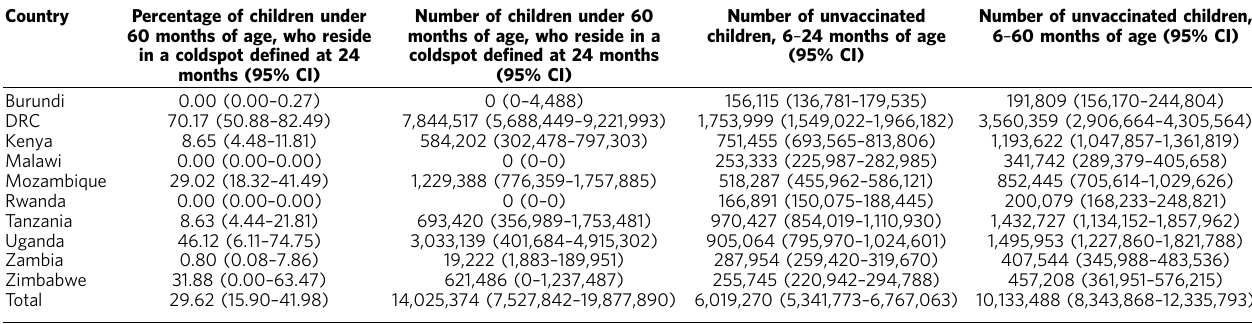
Table 2 | Children residing in coldspots and unvaccinated